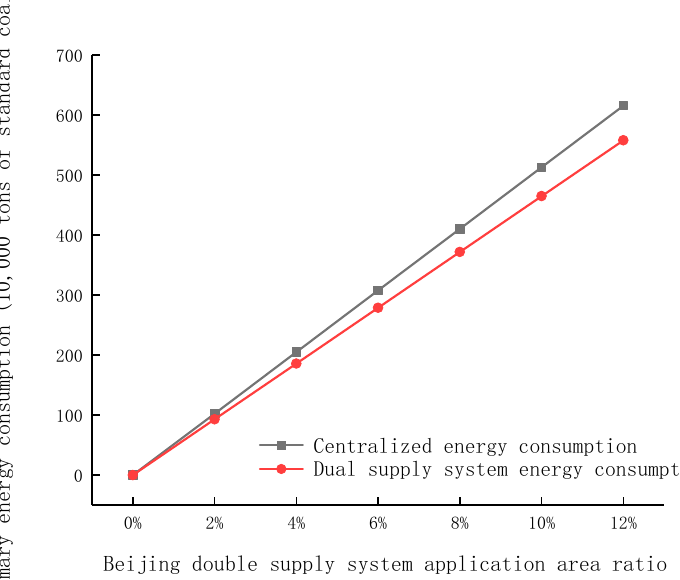
Figure 8. Relationship between application ratio of di ff erent energy supply system and primary energy consumption.